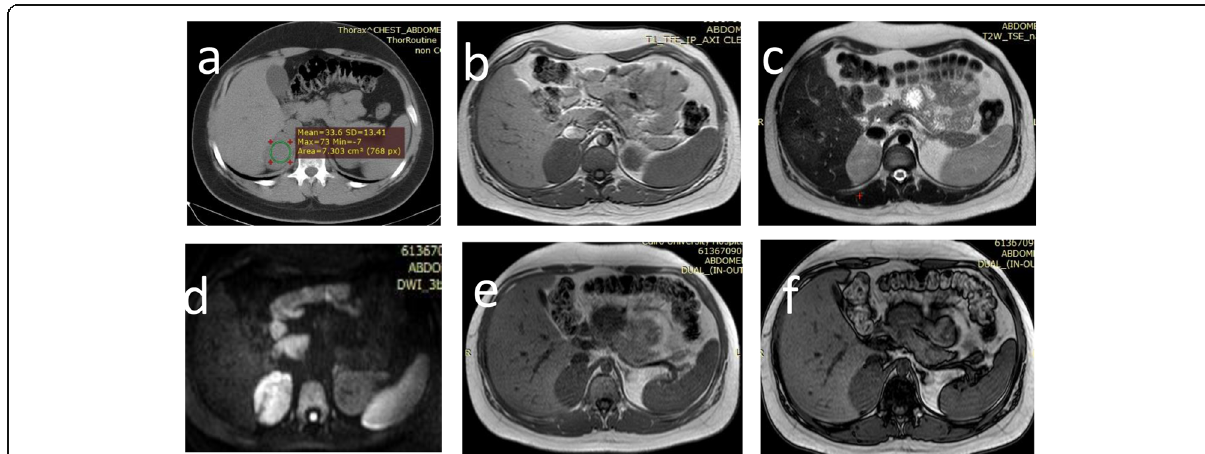
Fig. 5 A 19-year-old male patient with a brain SOL that was surgically removed and sent to pathology and diagnosed as lymphoma a MDCT axial cuts showing right suprarenal soft tissue mass lesion measuring 6.2 × 4.8 cm with a mean attenuation of 33 HU in unenhanced images. APW = 22% and RPW = 4% denoting poor lipid content. MRI abdomen suprarenal protocol showing right suprarenal soft tissue mass lesion of iso T1 signal ( b ), intermediate T2 signal ( c ), it shows diffusion restriction in d and no drop of signal in opposed phase images ( f ) compared to in phase 1 ( e ). Diagnosis was right suprarenal metastatic lesion